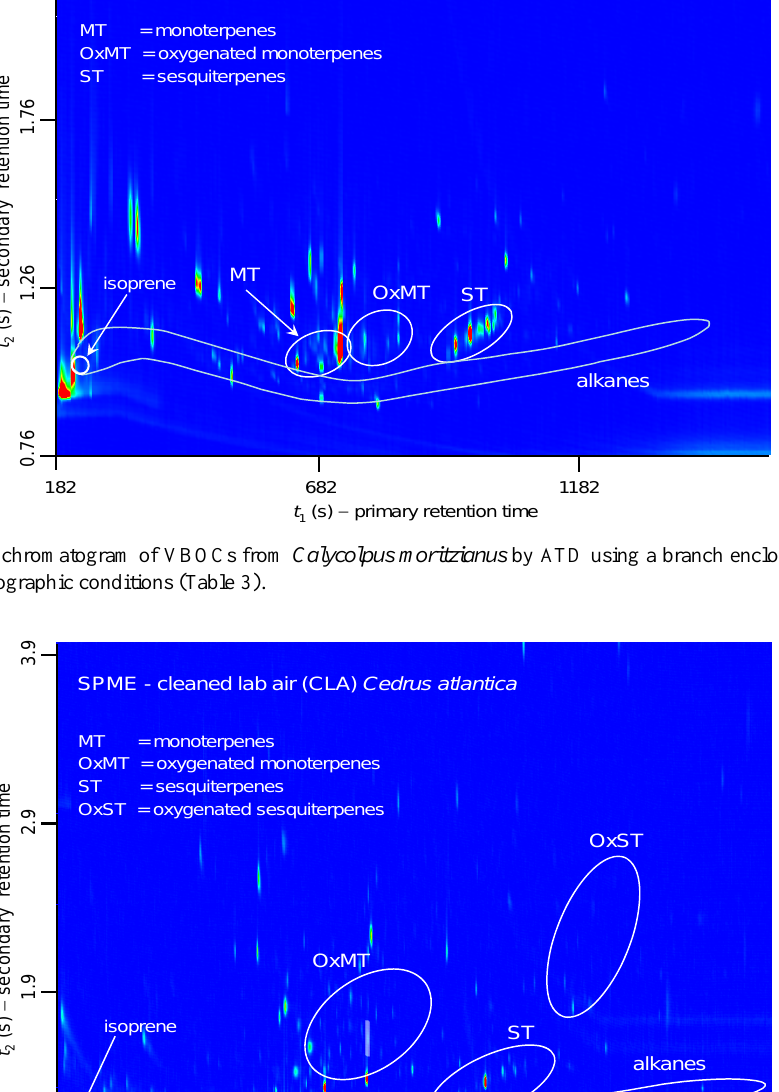
Figure 4 is a chromatogram for VBOCs emitted from Cedrus atlantica needles sampled in Portland